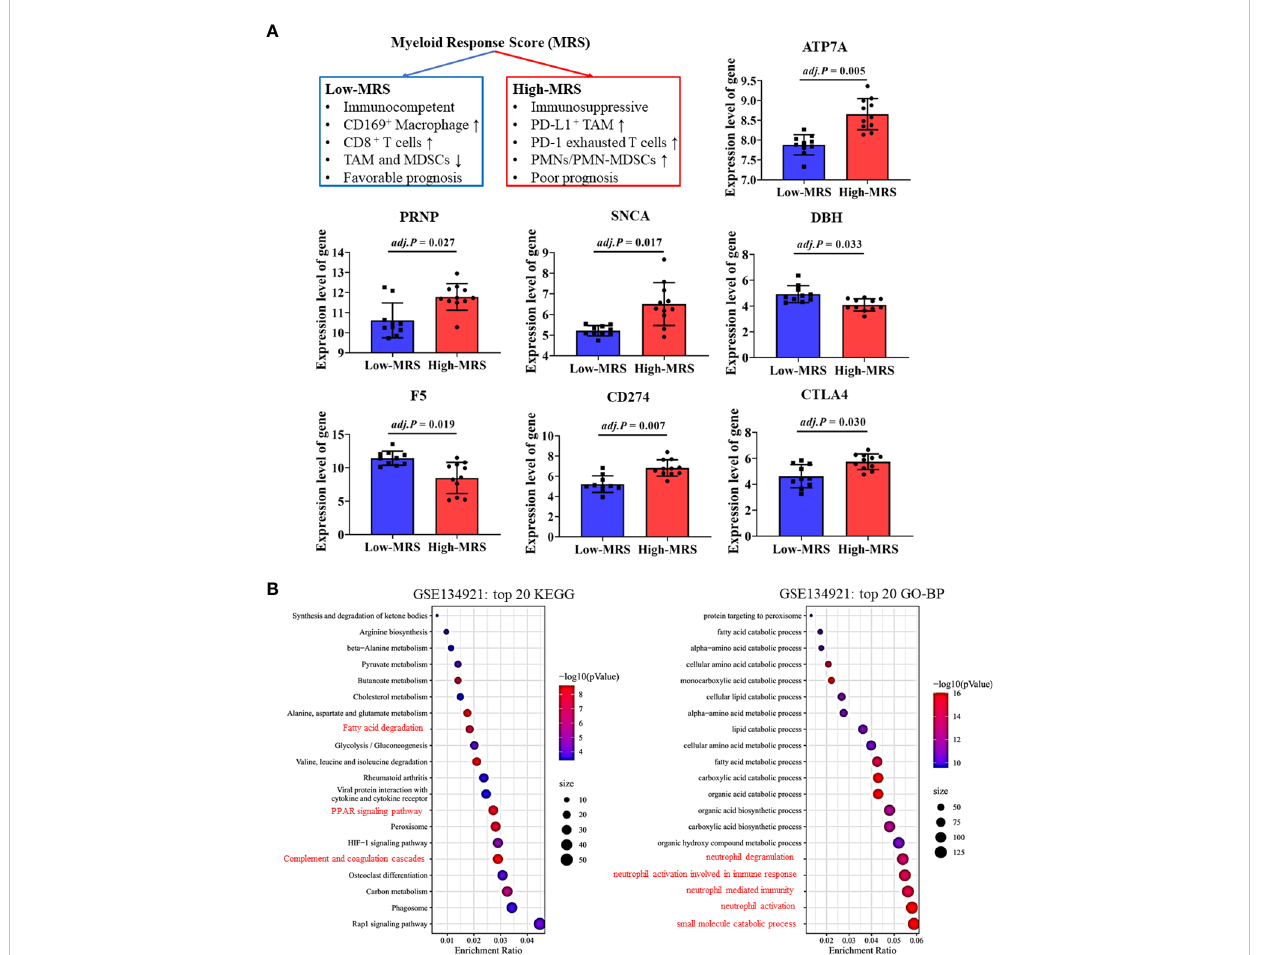
FIGURE 7 Validation of cuproptosis-related genes (CRGs) and immune checkpoint gene (ICG) expression in different immune subtypes of hepatocellular carcinoma (HCC). (A) Expression levels of critical CRGs and ICGs between the low-myeloid response score (MRS) group and high-MRS group. (B) Differential signal pathway analysis between the low- and high-MRS